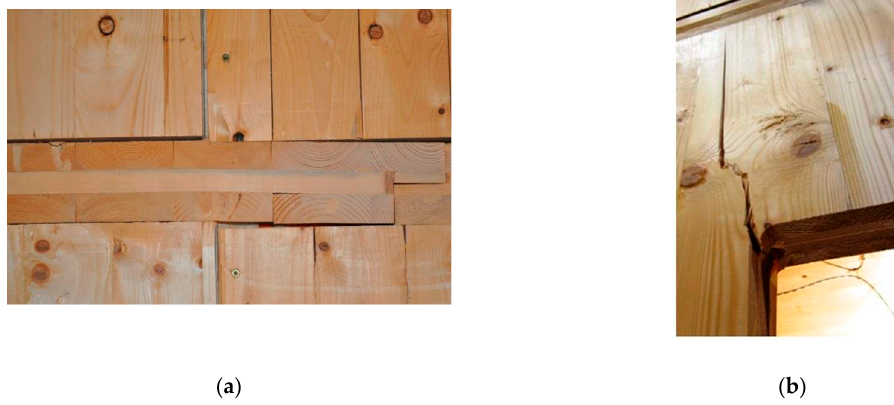
Figure 4. Timber panels damage observed in the quasi-static test of CLT buildings under large displacement: ( a ) embedment of wall panels into floor panels that causes the debonding of timber planks; ( b ) cracking in the corner of a large opening [19].